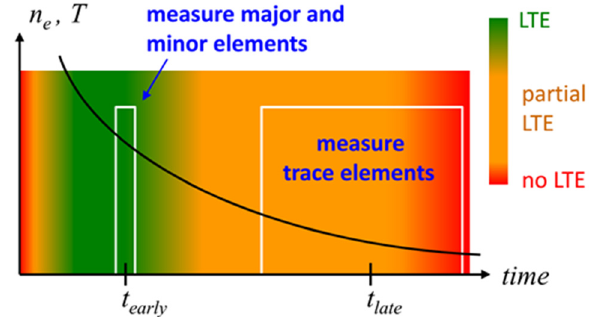
Figure 16. Time scheme for sensitivity-improved calibration-free LIBS: two spectra are recorded at different times. Probing the plasma in conditions of full LTE ( t early ) and partial LTE ( t late ) serves to quantify major, minor and trace elements, respectively. The color scale from green to red indicates the degree of equilibrium. Adapted from Reference [198].